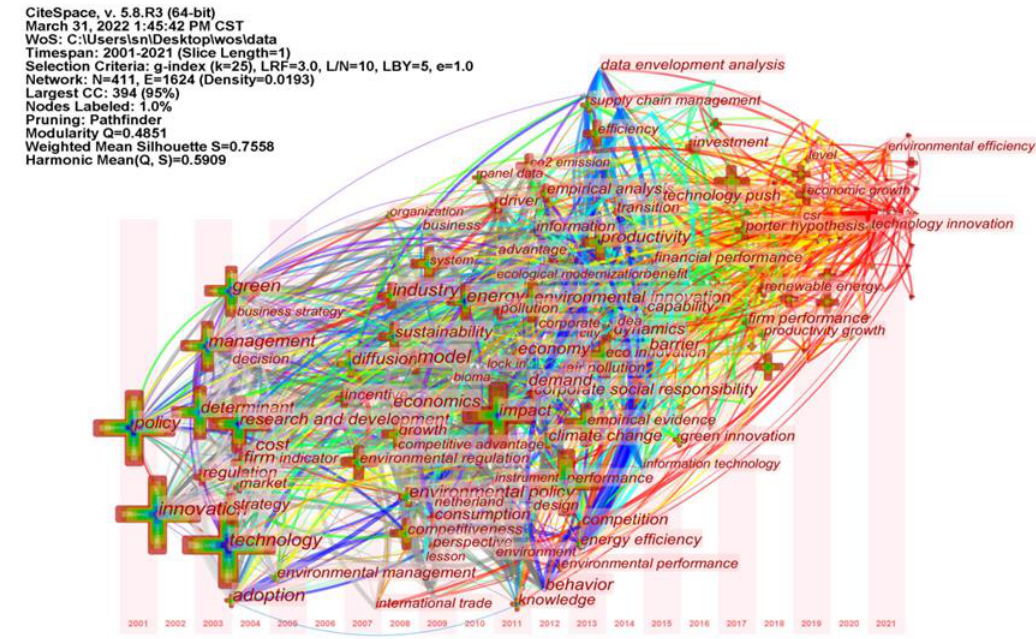
Figure 11. CiteSpace-based time zone mapping .